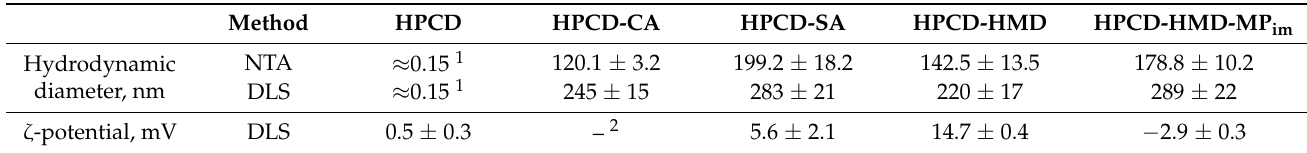
Table 1. The size and ζ -potential of HPCD polymers, H 2 O, 25 °C.